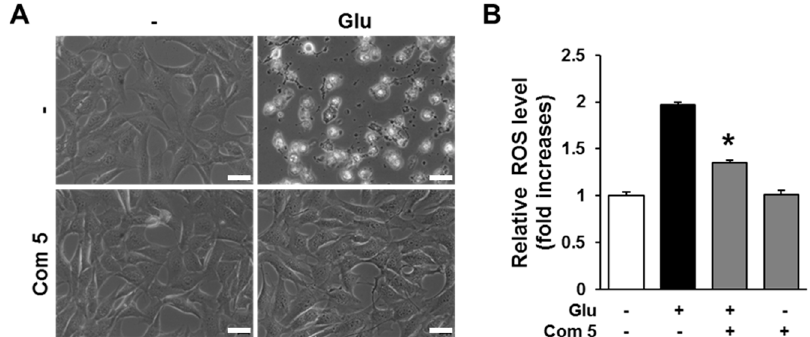
Figure 5. Compound 5 (Com 5 ) prevented glutamate-induced HT22 cell death through inhibition of intracellular ROS accumulation. ( A ) Phase contrast microscopic images of HT22 cells were obtained after exposure to 5 mM glutamate in the presence of 12.5 μ M Com 5 for 24 h. Scale bars, 20 μ m. ( B ) To access the levels of intracellular ROS, HT22 cells were exposed to 5 mM glutamate in the presence of 12.5 μ M Com 5 for 8 h and loaded with 2 ′ ,7 ′ -dichlorofluorescin diacetate (H 2 DCFDA). The fluorescence intensity of dichlorofluorescin (DCF) was measured using a fluorescent microplate reader. Bars denotes the fold increase of the fluorescence intensity of DCF compared with non-treated cells (mean ± S.E.M., * p < 0.05 compared with glutamate-treated cells). Intracellular ROS assays were done in triplicate and repeated at least three times.